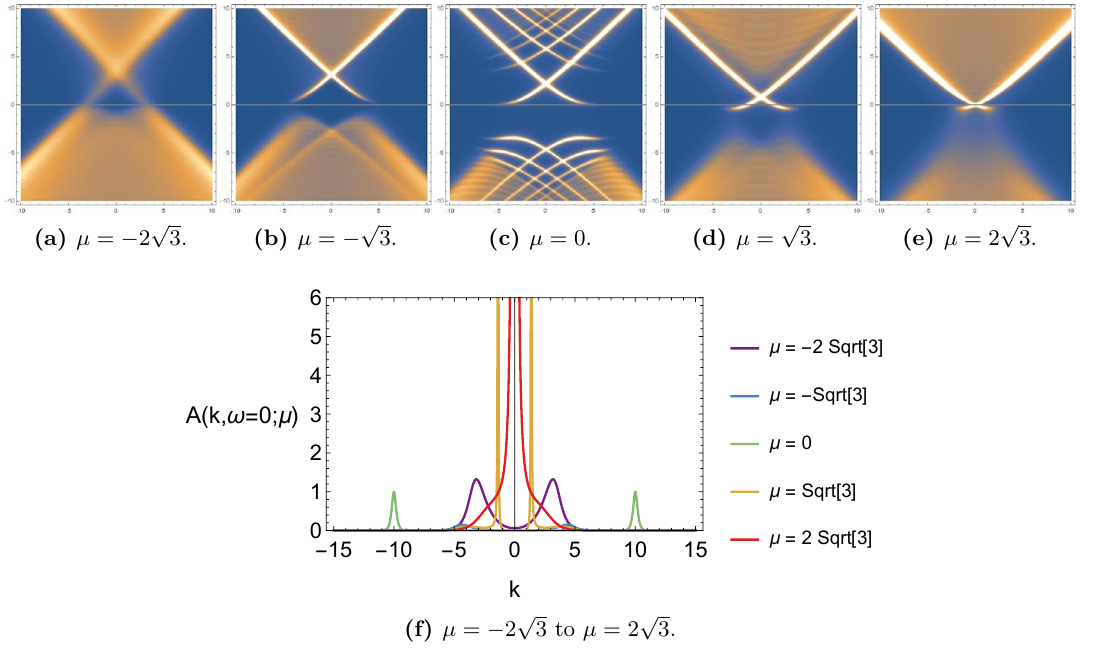
Figure 18. µ -evolution of SF of B rt interaction with condensation B plot in ( ω, k ) . (f):SF at the Fermi level. The minimum of DOS is at µ ’ − 1 .